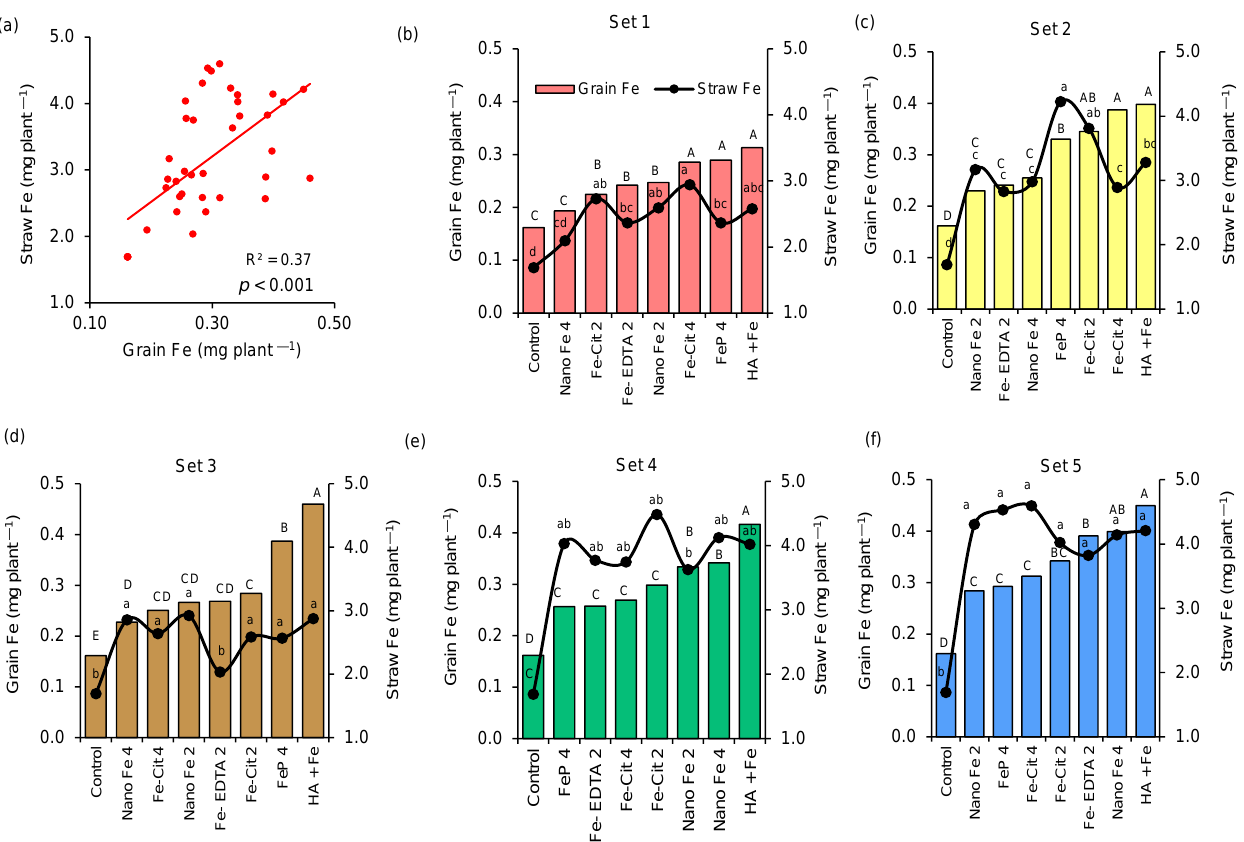
Figure 5. Influence of foliar application of Fe compounds on ( a ) a linear regression between grain Fe and straw Fe contents in rice (values are means of all 5 sets) and ( b – f ) grain Fe contents and straw Fe contents in different sets in rice. Data correspond to means ± SEm ( n = 5). The plants of set 1, set 2, and set 3 received single sprays in the tillering, anthesis, and grain-filling stages, respectively, while set 4 plants were sprayed twice (anthesis and grain-filling stages) and set 5 plants were sprayed in all growth stages. Each set was analyzed separately using a one-way ANOVA, and the least significant difference was calculated. Means with the same letter (uppercase for grain Fe content and lowercase for straw Fe content) were not significantly different at p < 0.05.